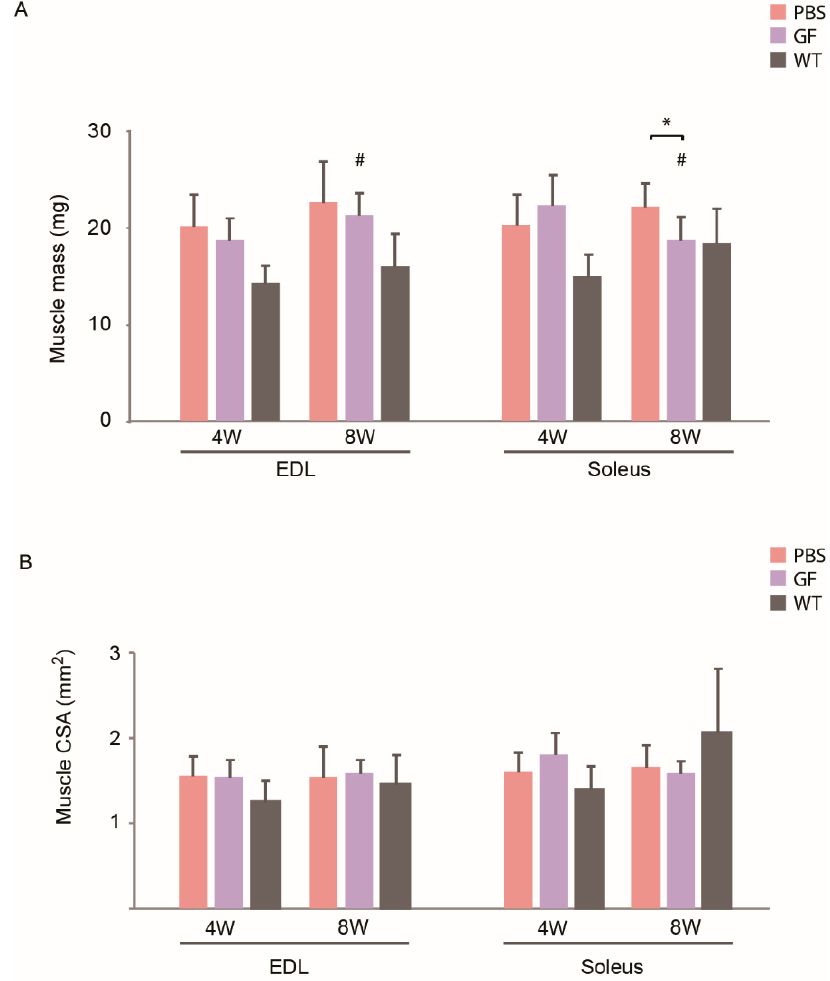
Figure 2. Muscle mass ( A ) and CSA ( B ) of hind-limb muscles of young (4W) and adolescent (8W) mdx mice treated for 12 weeks with growth factors. N for 4W animals: PBS, 12; GF, 11; WT, 11. N for 8W animals: PBS, 12; GF, 9; WT, 12. CSA, cross-sectional area; EDL, m. extensor digitorum longus; GF, growth factor; PBS, phosphate-buffered saline; WT, wild-type strain. Data presented as mean and vertical bars representing SD. Two-way ANOVAs were performed with subsequent Tukey HSD post-hoc tests to assess significance. Horizontal bars indicate significance: * p < 0.05, # p < 0.05 vs. 4W animals.